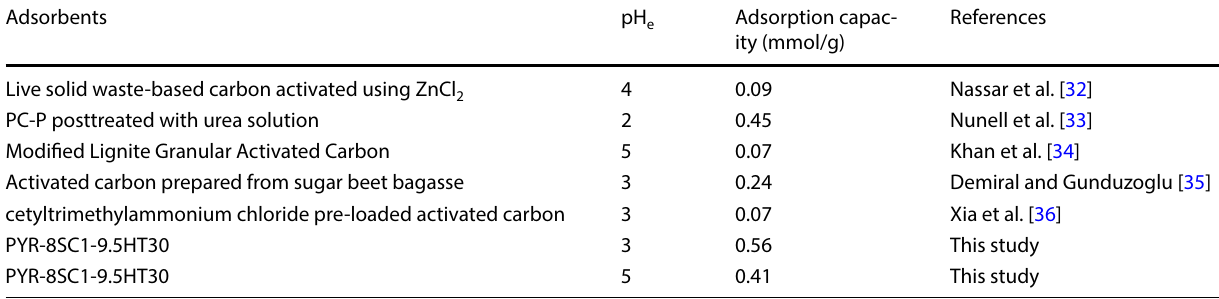
Table 6 Comparison of nitrate ions adsorption on various adsorbents